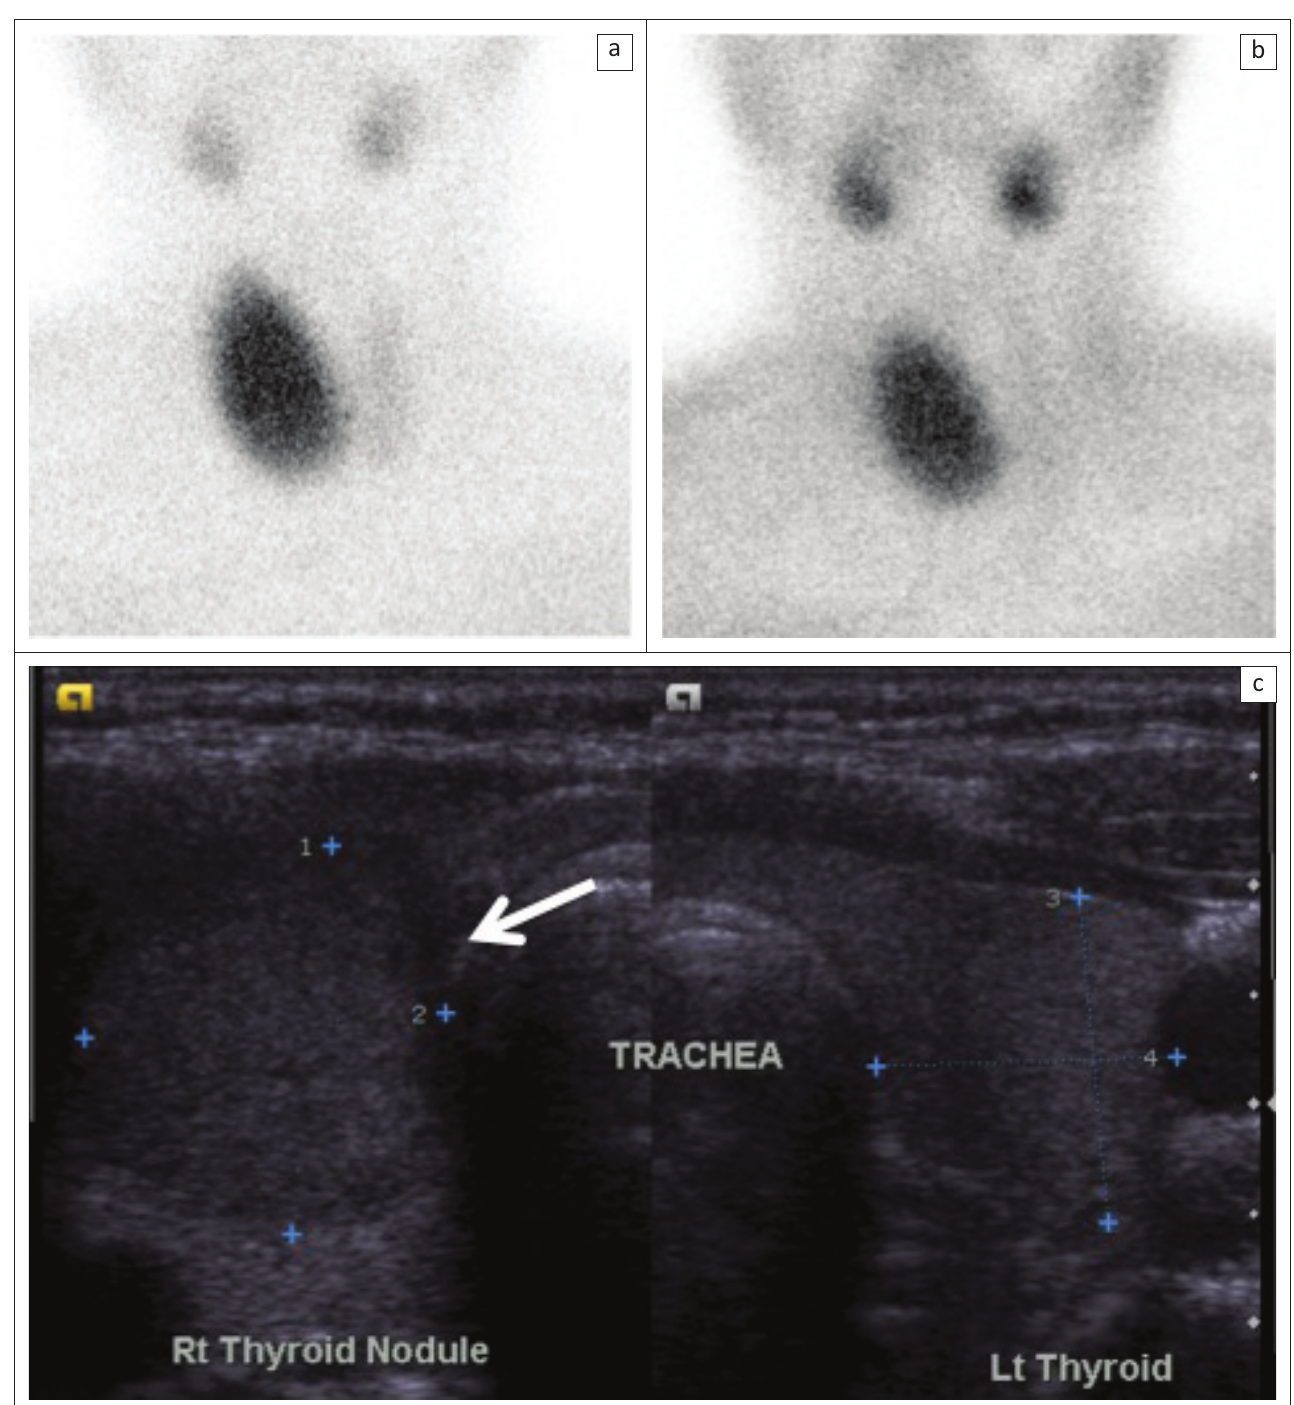
FIGURE 3: 99mTc-MIBI scintigraphy and ultrasonography of the thyroid of a 42-year-old woman with right thyroid nodule. Intense 99mTc-MIBI uptake on early (a) and delayed (b) images is noted in the right lobe of the thyroid. Ultrasonography (c) showed a well-defined mass that is taller than wider shape (arrowed). The features on the two studies are suggestive of malignancy. Histology confirmed a follicular